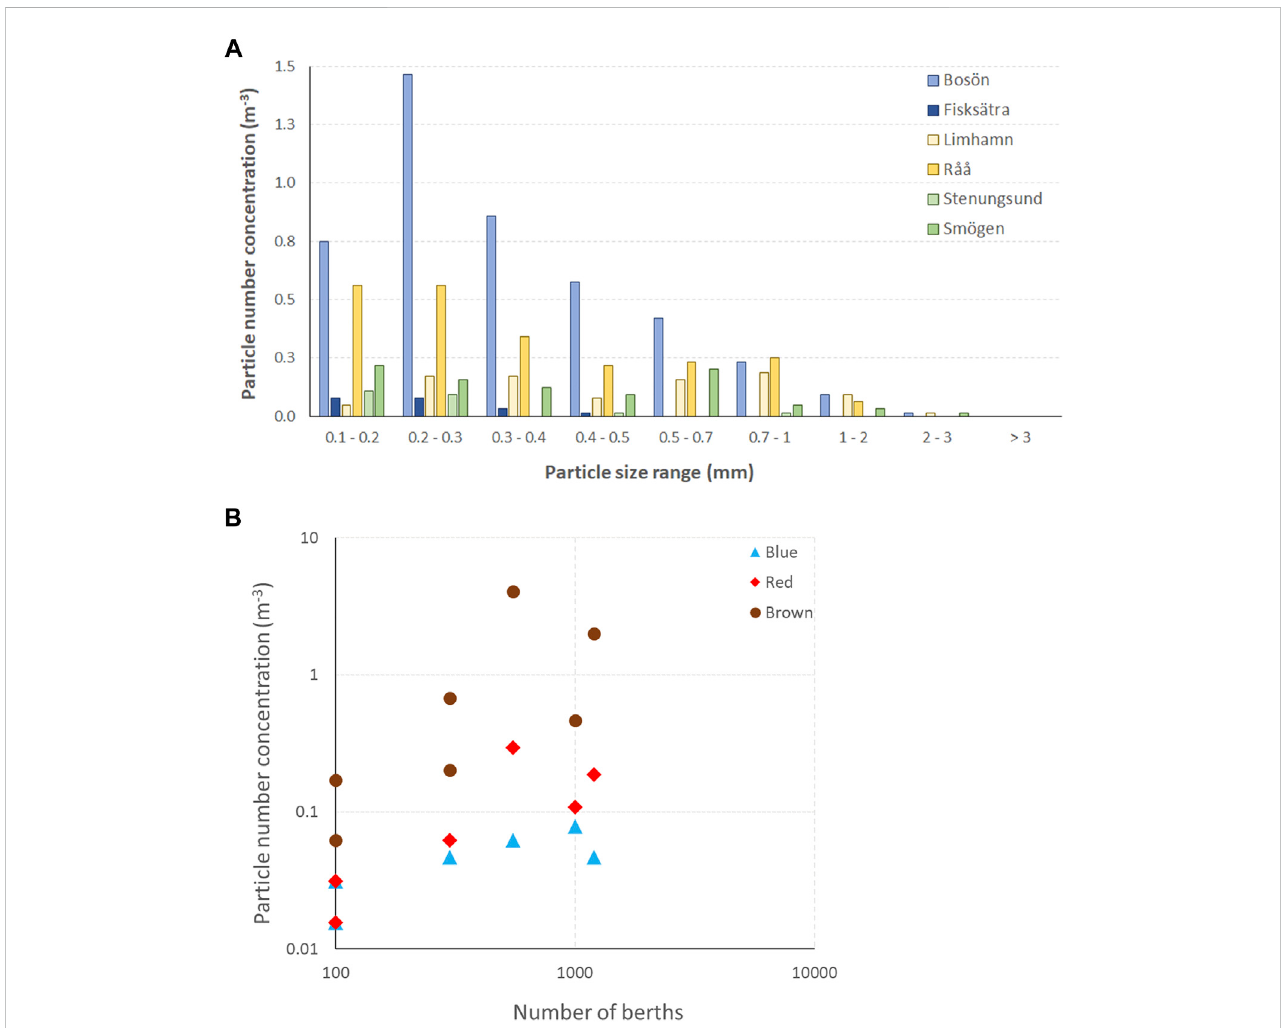
FIGURE 3 (A) : Size distribution of particles collected with manta trawl (300 µm) and detected with automated LM method. (B) : Particle number concentration plotted against the number of berths in the marinas sampled (axes are plotted on log